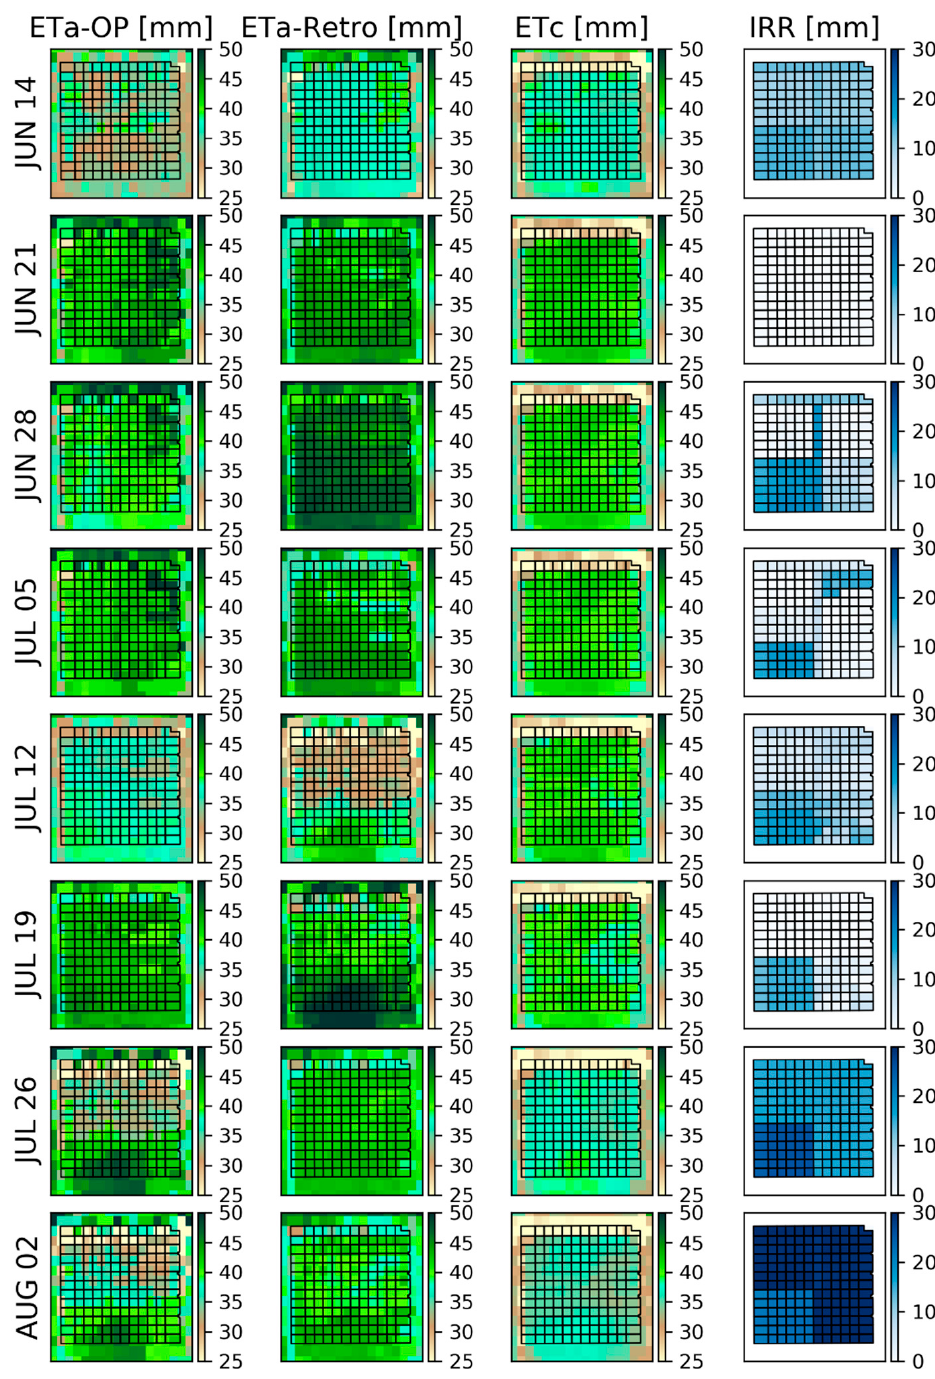
Figure 6. Spatial maps of ET a -OP (left column), ET a -retro (second from left column), ET c (third from left column), and applied irrigation (right column) over the VRDI (black grid) equipped vineyard for the weekly model completion dates specified on the y-axis. Note that scales are held constant between ET models and dates to represent time varying changes in modeled ET.